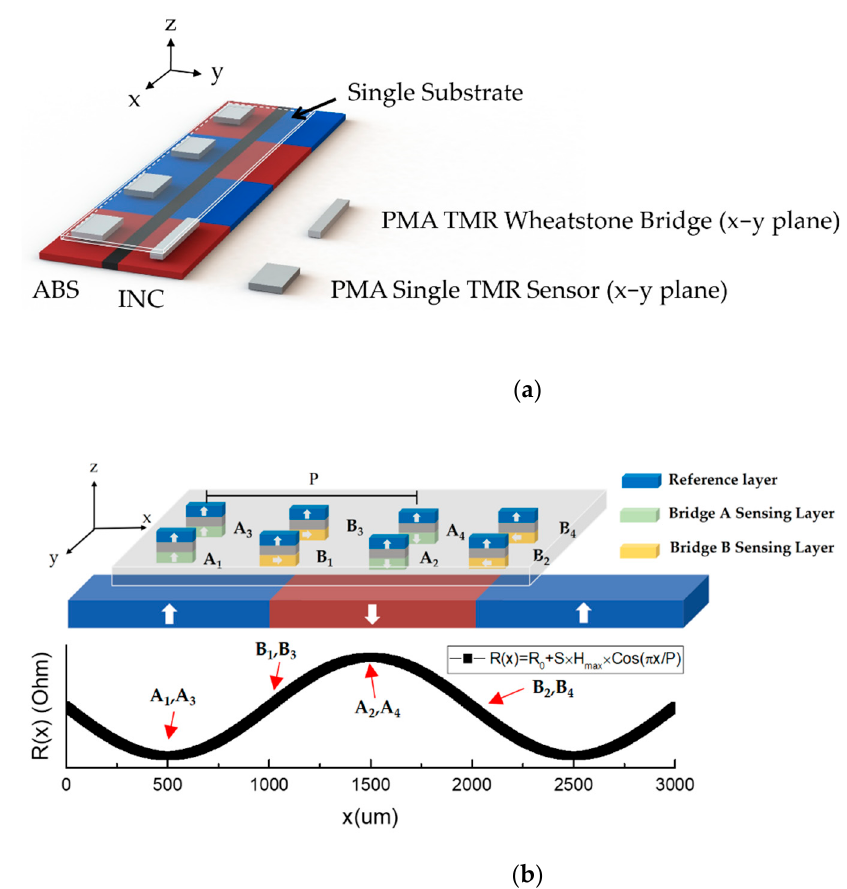
Figure 3. ( a ) The proposed integrated system consisting of identical TMR sensors on a single substrate. ( b ) The illustration for the magnetization directions of SL and RL in the TMR sensor for the INC line placed in the x–y plane, and the corresponding resistance for each MTJ at different positions.